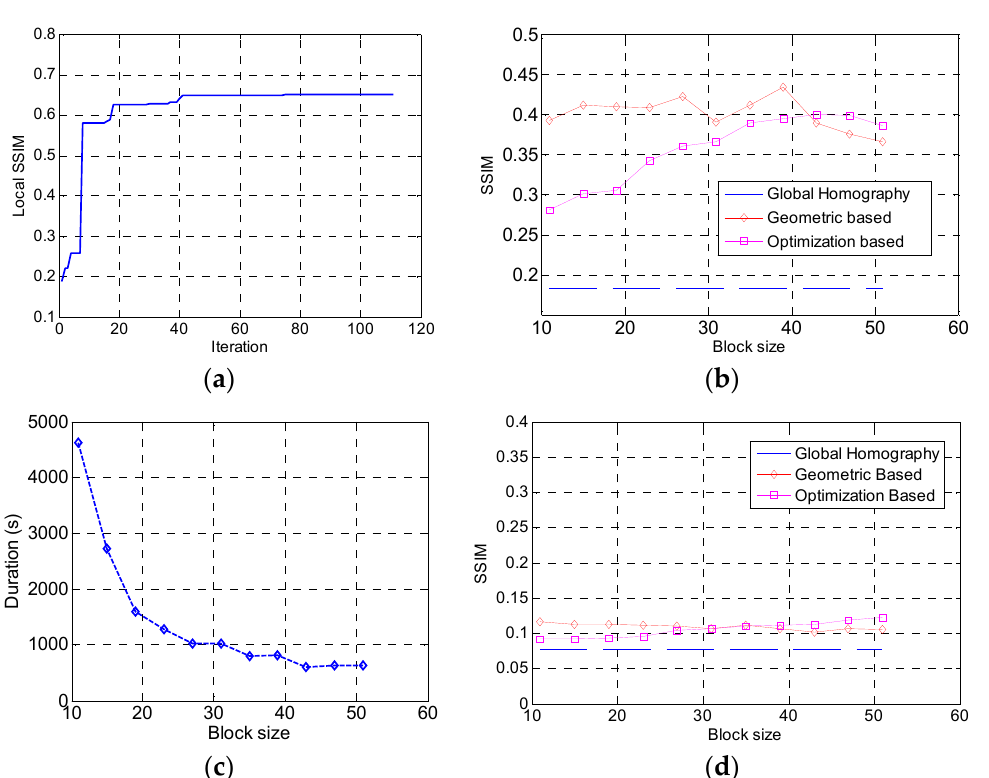
Figure 14. ( a ) An example for the change of the local SSIM for a sample block with respect to the iteration number in the optimization-based refinement. ( b ) Global SSIM vs. block size for optimization- and geometric-based refinements for the same-day pair, LWIR1 a – LWIR1 b . ( c ) Duration vs. block size for the optimization-based refinement and ( d ) global SSIM vs. block size for a different-day pair, LWIR1 a – LWIR1 c .